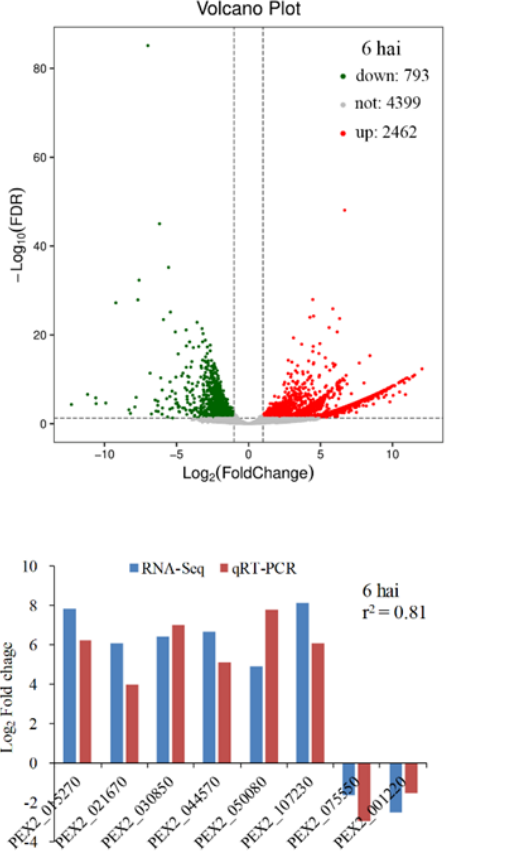
Figure 2. RNA-Seq analysis of Penicillium expansum during infection of apple fruits. ( a ) Volcano plot of all DEGs in Penicillium expansum at 6 and 9 hai. The red and green spots represent the up-regulated and down-regulated genes, respectively. ( b ) qRT-PCR validation of RNA-Seq data.